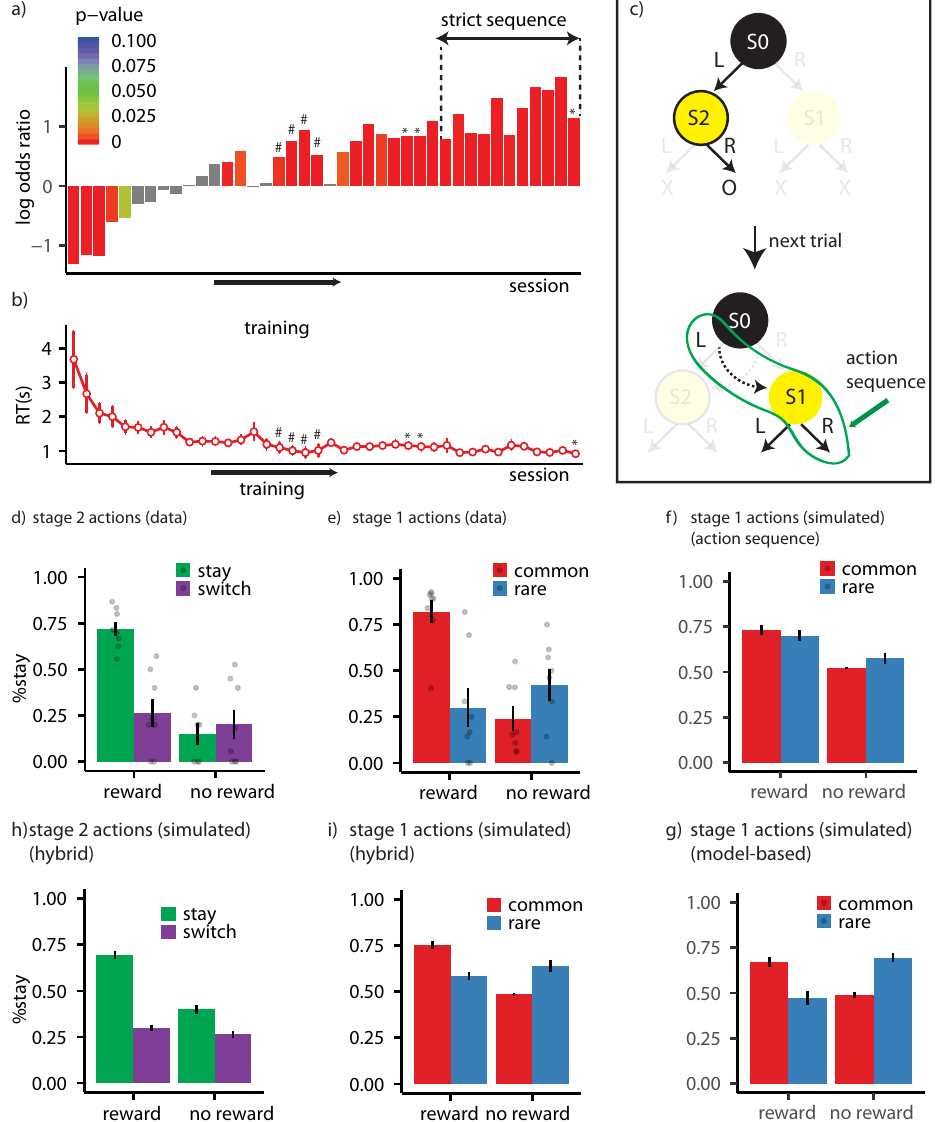
included. (e) The probability of staying on the same stage 1 action in the probe session averaged over subjects as a function of whether the previous trial was rewarded (reward/no reward) and whether the transition in the previous trial was common or rare. (f) Model simulations depicting the probability of staying on the same stage 1 action when the model is using exclusively action sequences. (g) Model simulations depicting the probability of staying on the same stage 1 action when the model is using the true state-space of the task but not action sequences. (h) Simulation of stage 2 choices, and (i) stage 1 choices using the best-fitted parameters for each subject. Error bars represent ± 1